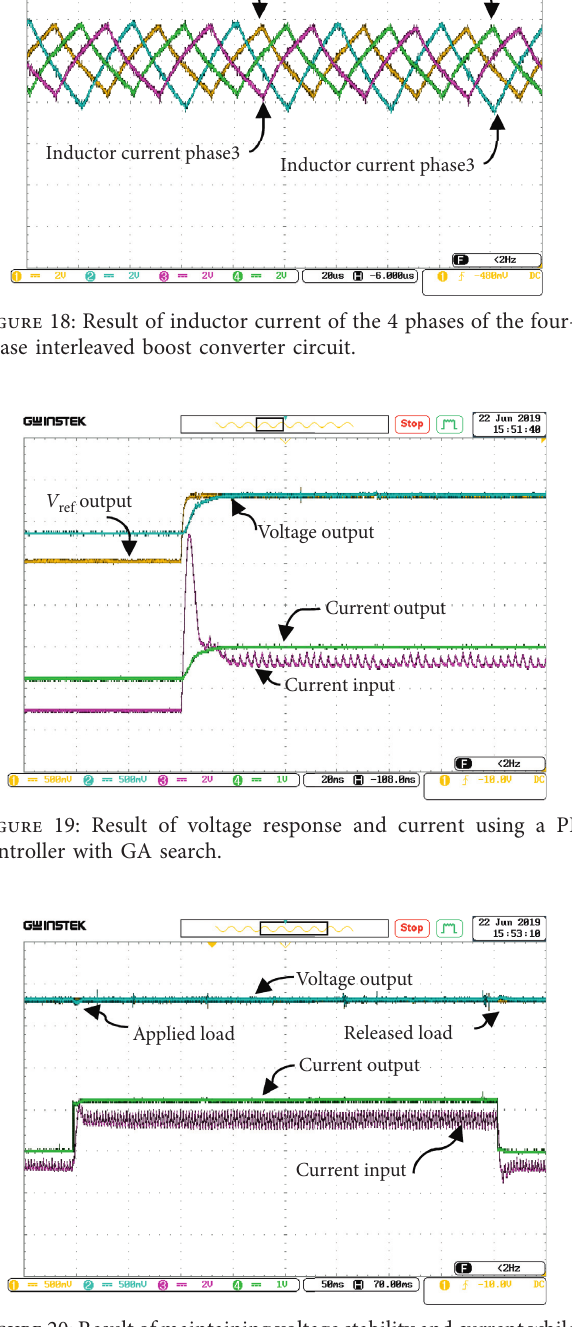
Figure 20: Result of maintaining voltage stability and current while changing load using a PI controller with GA